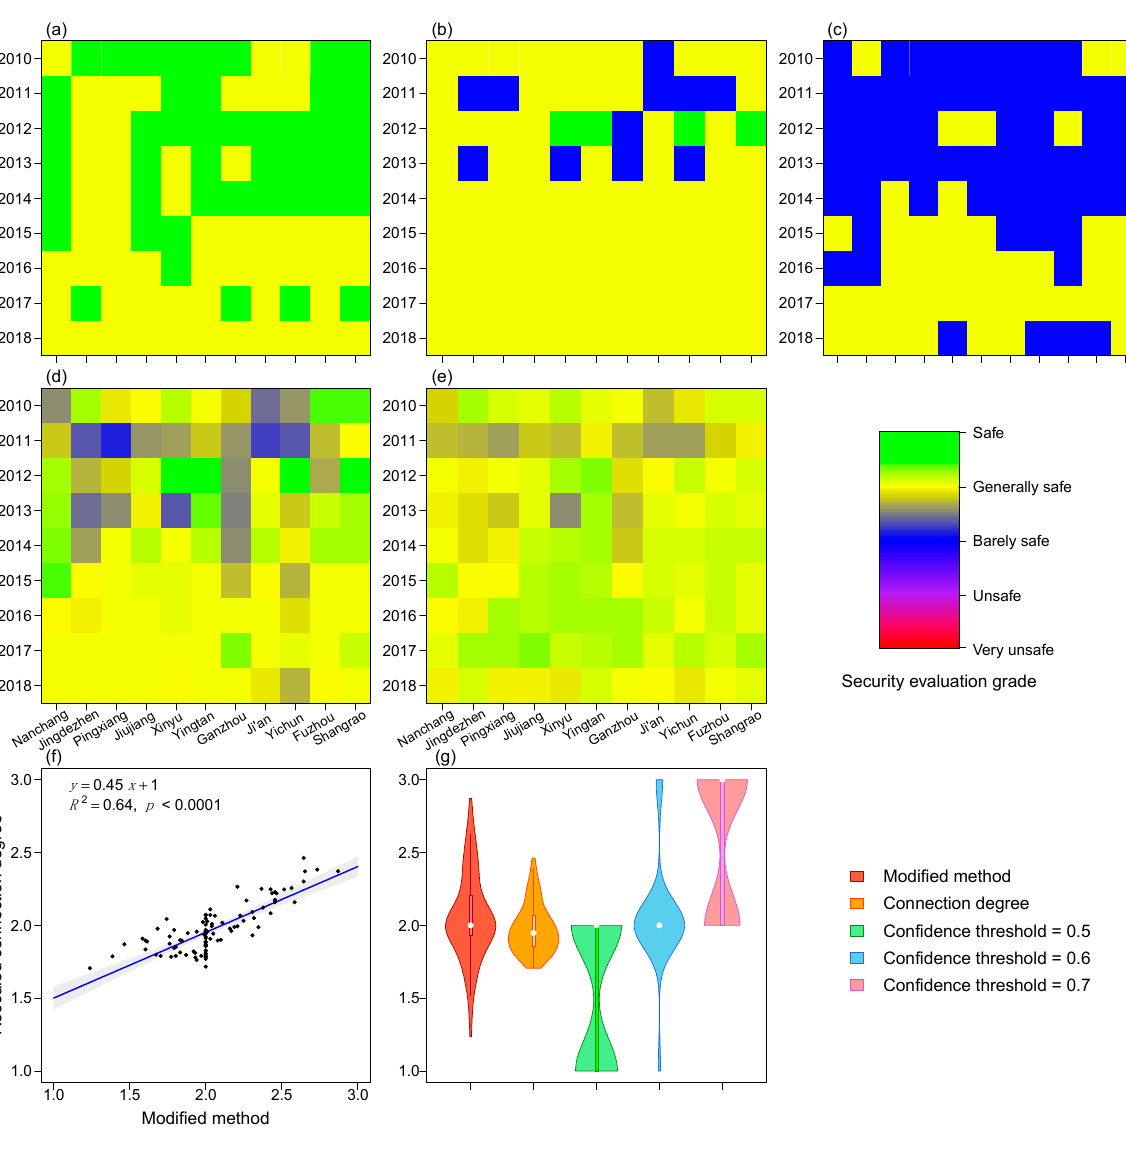
Figure 2. ( a – c ) Water resource security grade with λ = 0.5,0.6,0.7; ( d ) water resources security using the graded confidence threshold; ( e ) connection degree rescaled from 0–1 to 1–5; ( f ) correlation between the modified method and the connection degree; ( g ) distributions of water security scores in all methods; here, 1 is Safe, and 3 is Barely safe.